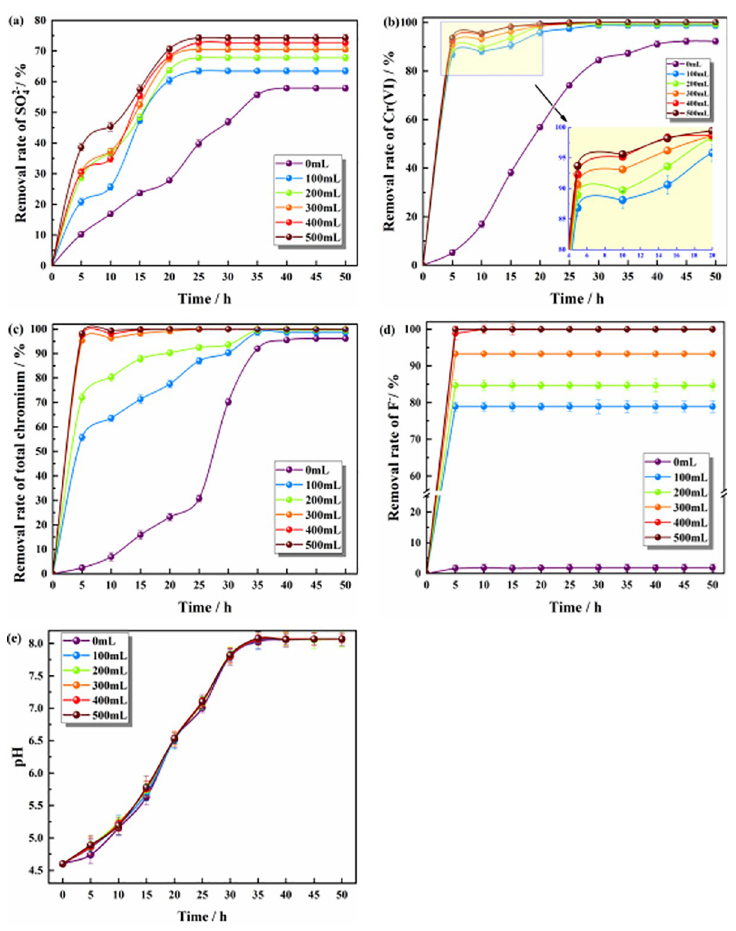
Fig 4. Effect of different dosages of hybrid materials on pollutants. (a) The effect on the removal of SO 42- ; (b) The effect on the removal of Cr(VI); (c) The effect on the removal of total chromium; (d) The effect on the removal of F - ; (e) The effect on the pH